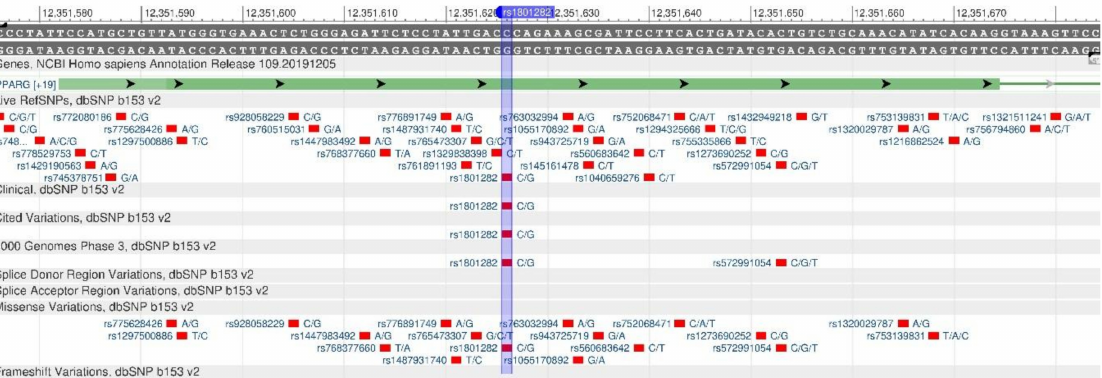
Figure 6. A portion of the PPARG gene (located on the short (p) arm of chromosome 3) containing the oligonucleotide polymorphism rs1801282.